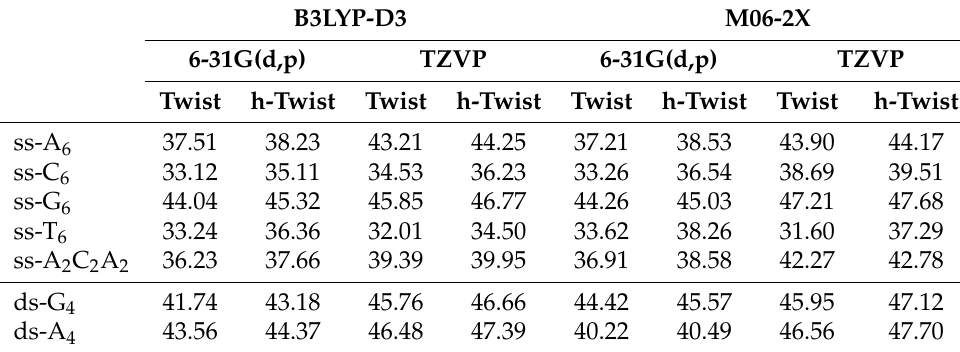
Table 2. Predicted average twist and helical twist